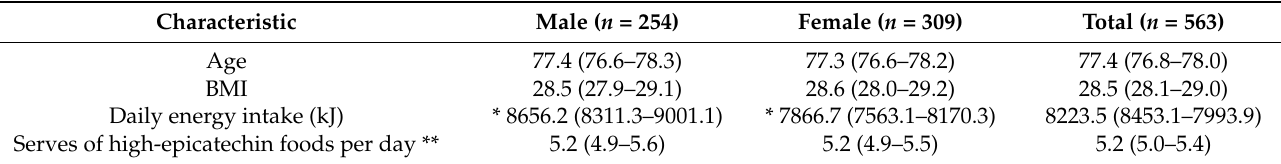
Table 2. Participant characteristics reported as the mean (95% CI).